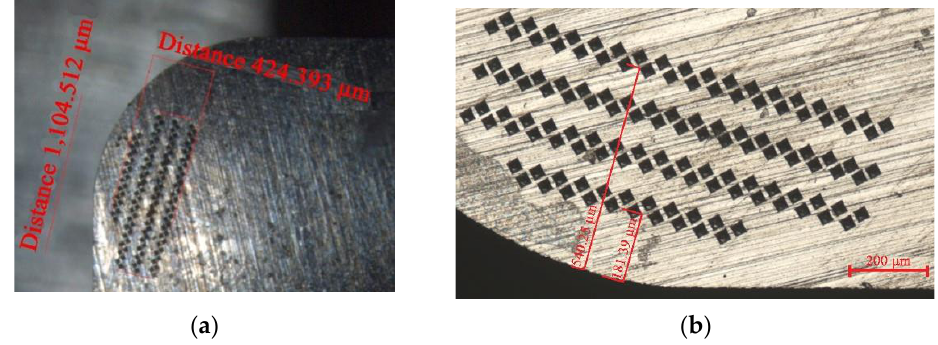
Figure 4. Final view of microtextures: ( a , b ) the microtexture location on the rake